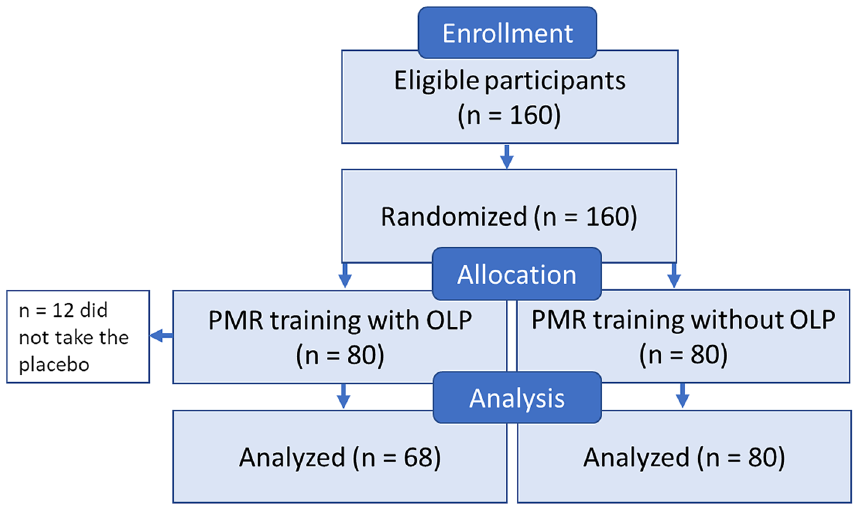
Figure 2. Consort flow diagram. PMR progressive muscle relaxation, OLP open-label